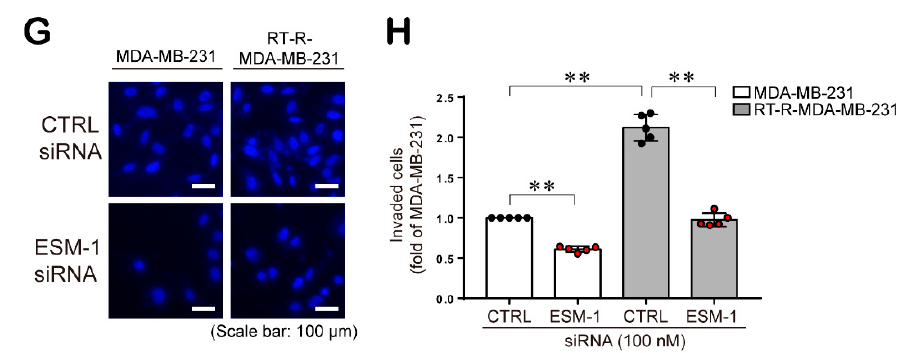
Figure 2. ESM-1 plays an important role in the proliferation, colony formation ability, migration, and invasion of both MDA-MB-231 and RT-R- MDA-MB-231 cells. ( A ) Cells were transfected with CTRL or ESM siRNA (100 nM) as described in the methods section, and gene silencing efficiency in MDA-MB-231 and RT-R-MDA-MB-231 cells was determined by RT-PCR. The full blot image can be found in Figure S2. ( B ) CTRL or ESM-1 siRNA-transfected MDA-MB-231 and RT-R-MDA-MB-231 cells were subjected to a cell proliferation assay using CCK-8 reagent as described in the methods section. The data represent the mean ± SD of five independent experiments. ( C,D ) CTRL or ESM-1 siRNA- transfected cells (1 × 10 3 ) were seeded in 6-well plates, and 10 days later, colonies were stained with Giemsa solution (0.1%) ( C ) and quantified under a light microscope as described in the methods